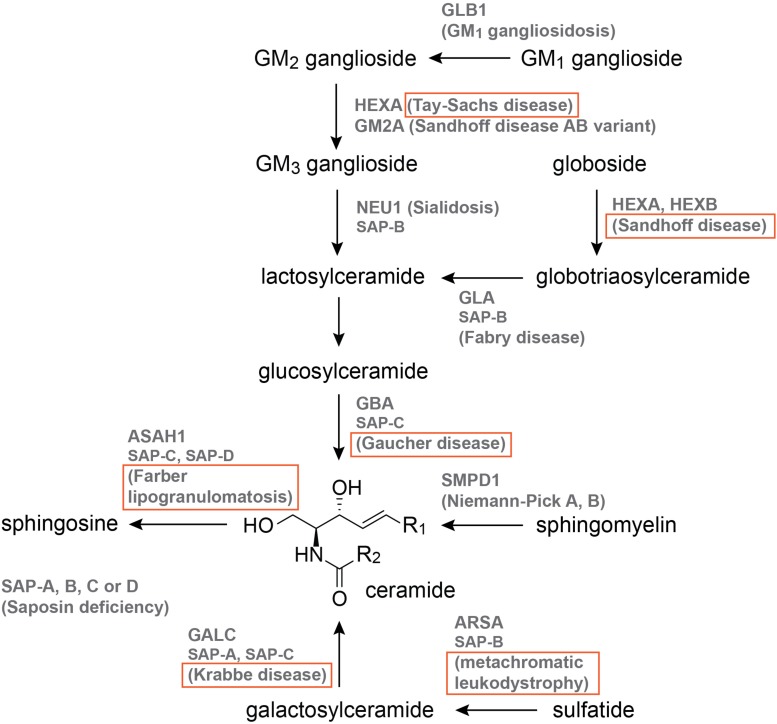
The sphingolipid catabolic pathway. Names that are boxed have published zebrafish models. Pathway illustration is based on Özkara (2004).